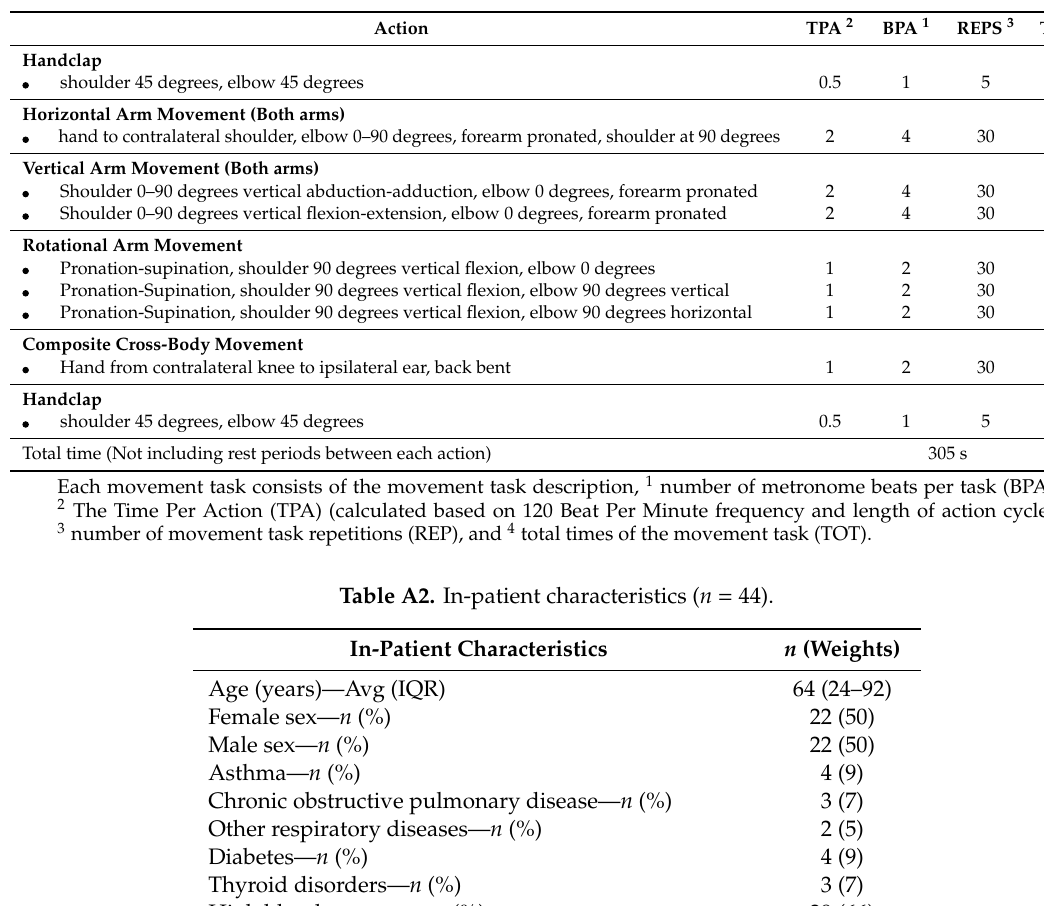
Table A1. Movement Sequence Protocol.